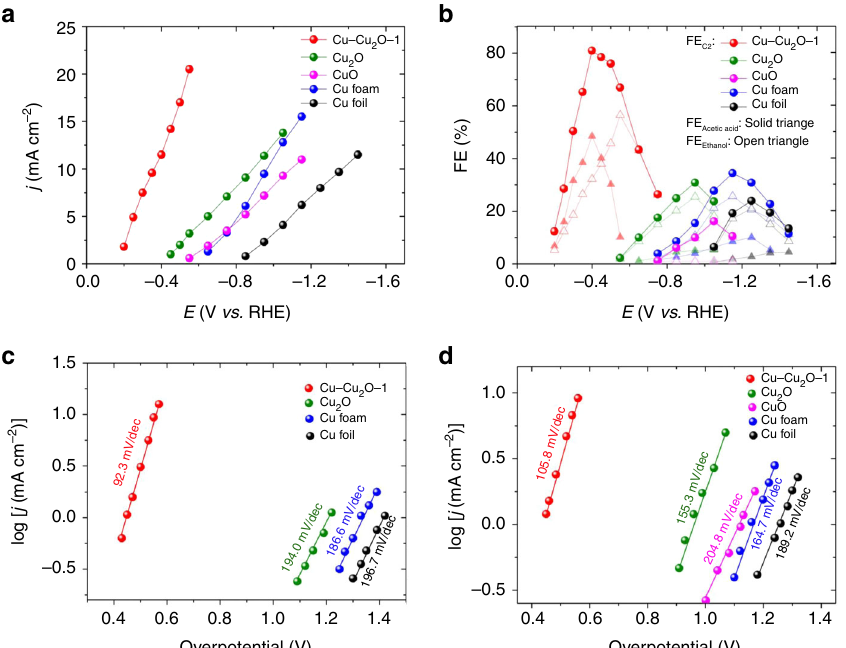
Fig. 3 Carbon dioxide reduction over various copper-based electrocatalysts. a The total current density at different applied potentials; b Faradaic ef fi ciencies of the C 2 products at different applied potentials; c , d Dependence of partial current density of acetic acid and ethanol on overpotential. Data were collected at room temperature and ambient pressure; electrolyte, 0.1 M KCl; CO 2 stream, 5